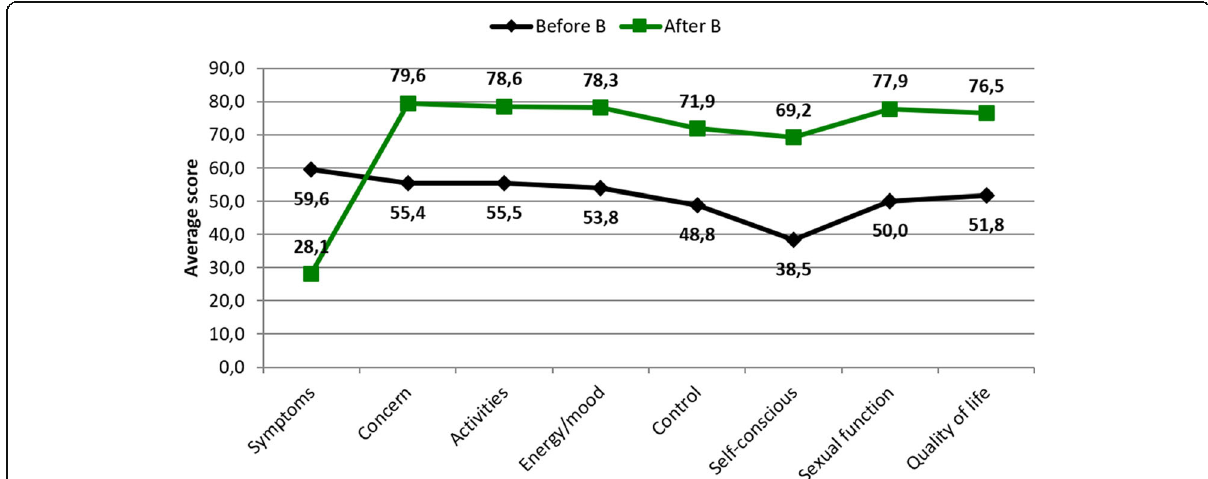
Fig. 4 Average score obtained in the UFS-QOL questionnaire, before and after UFE, in group B